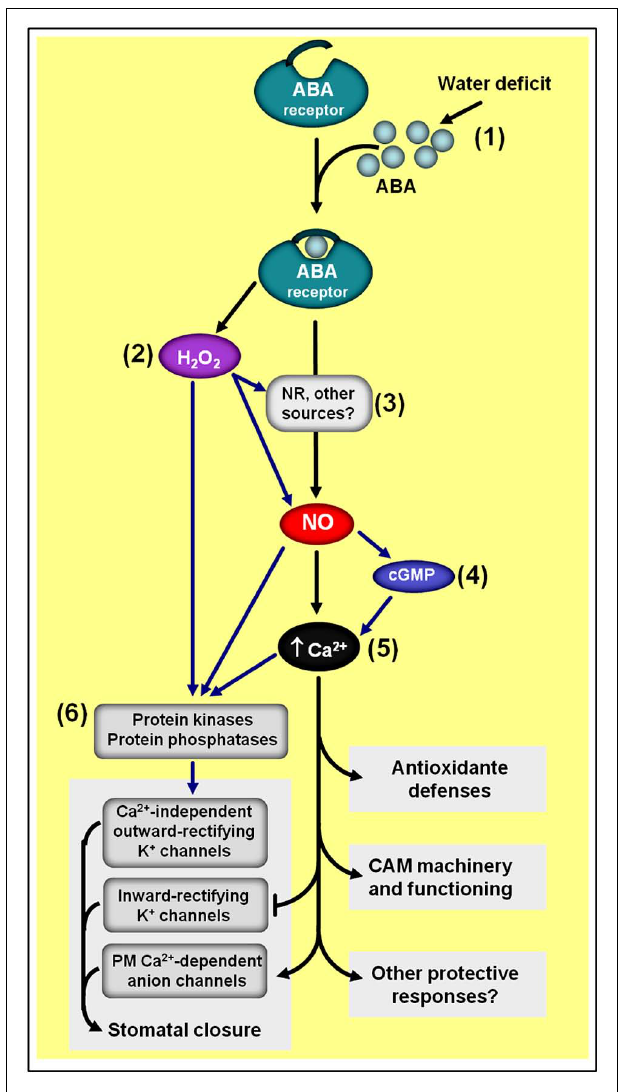
FIGURE 6 | Simplified schematic representation of NO–ABA interactions during defense responses to water shortage. (1)Water deficiency usually increases endogenous ABA levels. (2) ABA-induced NO generation depends on hydrogen peroxide (H 2 O 2 ) synthesis. (3) NR seems to be one of the main sources of ABA-induced NO production. (4) NO-triggered changes in cytosolic calcium (Ca 2 + ) seem to involve cyclic guanosine monophosphate (cGMP). (5)The calcium/calmodulin system is a key downstream element of NO/ABA signaling. (6) Protein kinases and phosphatases are typical targets of H 2 O 2 , NO, and Ca 2 + /calmodulin during ABA-induced responses. Black arrows indicate signaling steps shared by all three drought responses considered in the scheme (i.e., stomatal closure, antioxidant defenses, and Crassulacean acid metabolism induction). Blue arrows indicate some steps currently described only for the regulation of stomatal closure and/or antioxidant defenses. ABA- and NO-independent signaling pathways are not represented in this schematic